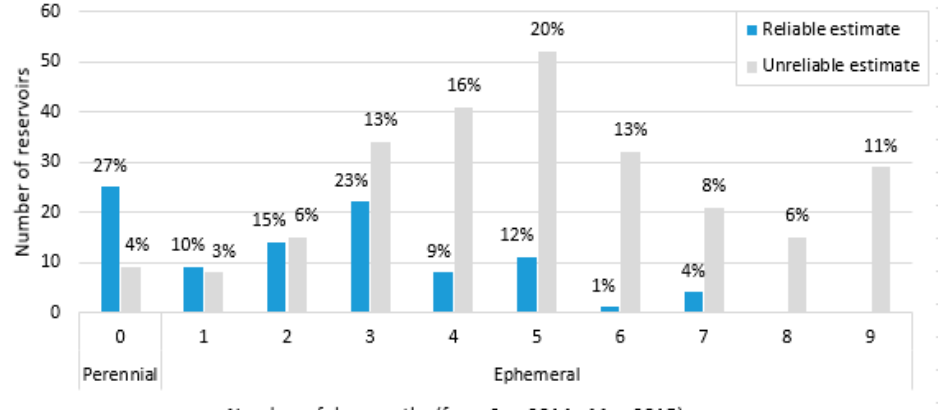
Figure 5. Seasonality of a subset of reservoirs (n = 350), for which valid GSW derived reservoir area estimates were available from September 2014 to May 2015. The figure shows the number of months a reservoir was recorded as dry distinguishing reservoirs where the mean monthly change in area was larger than the RMSE in GSW derived area estimates (“Reliable estimate”, n = 94) from reservoirs where the monthly area change was equal to or smaller than the RMSE (“Unreliable estimate”, n = 256).